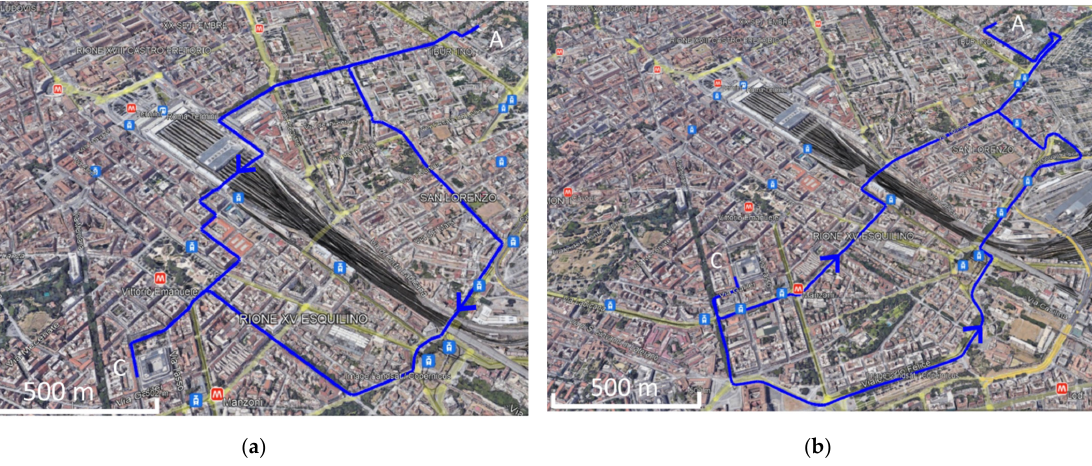
Figure 7. Google Earth maps of point-to-point routes: ( a ) Routes between points A and C (route 4 and route 8); ( b ) Routes between points C and A (route 9 and route 10).